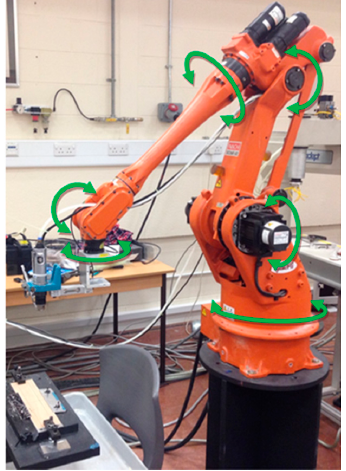
Figure 2. Nachi SC06F-02 robotic arm.